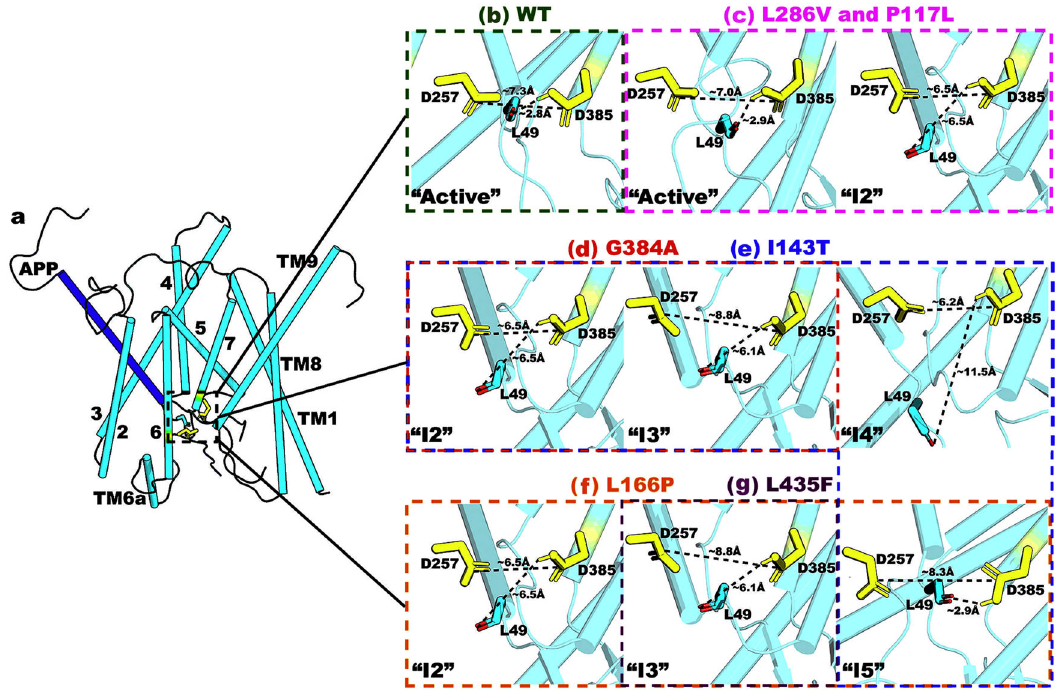
Fig. 6 Summary of the effects of PS1 FAD mutations on the ε cleavage of APP by γ -secretase. a Structural model of APP-bound PS1. The APP substrates are more tilted in the PS1 FAD mutants compared to WT γ -secretase. b The “ Active ” WT γ -secretase. c The active site of the L286V and P117L PS1 FAD mutants. d , e The active site of G384A ( “ I2 ”–“ I3 ” ) and I143T ( “ I2 ”–“ I5 ” ) PS1 FAD mutants. f , g The active site of the L435F ( “ I3 ” ) and L166P ( “ I2 ”–“ I3 ” and “ I5 ” ) PS1 FAD